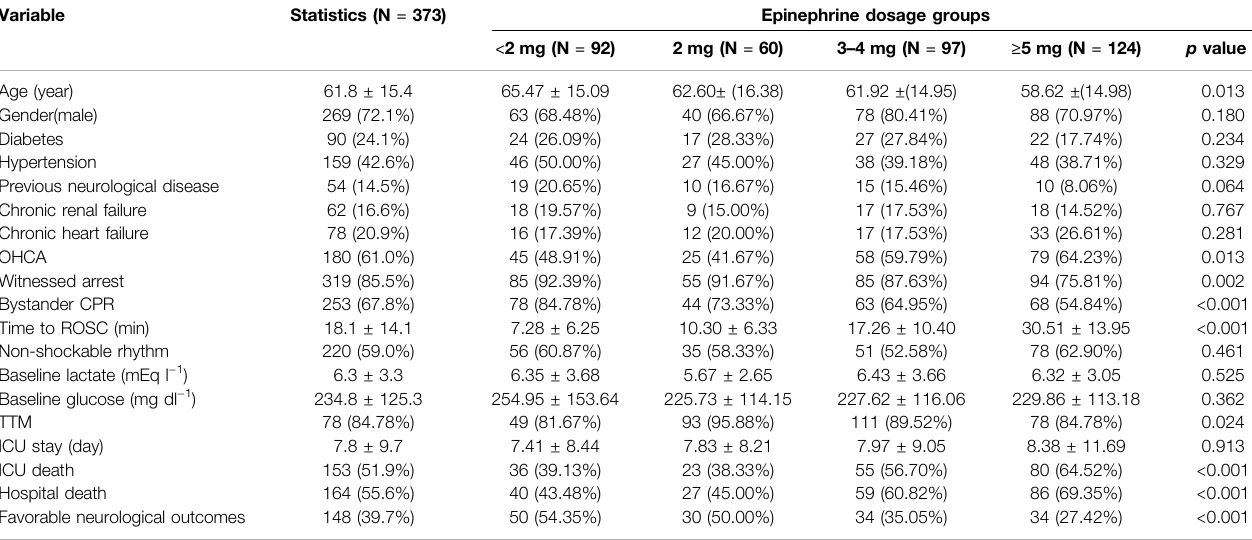
TABLE 1 | Clinical characteristics of patients at the time of hospital admission. Variable